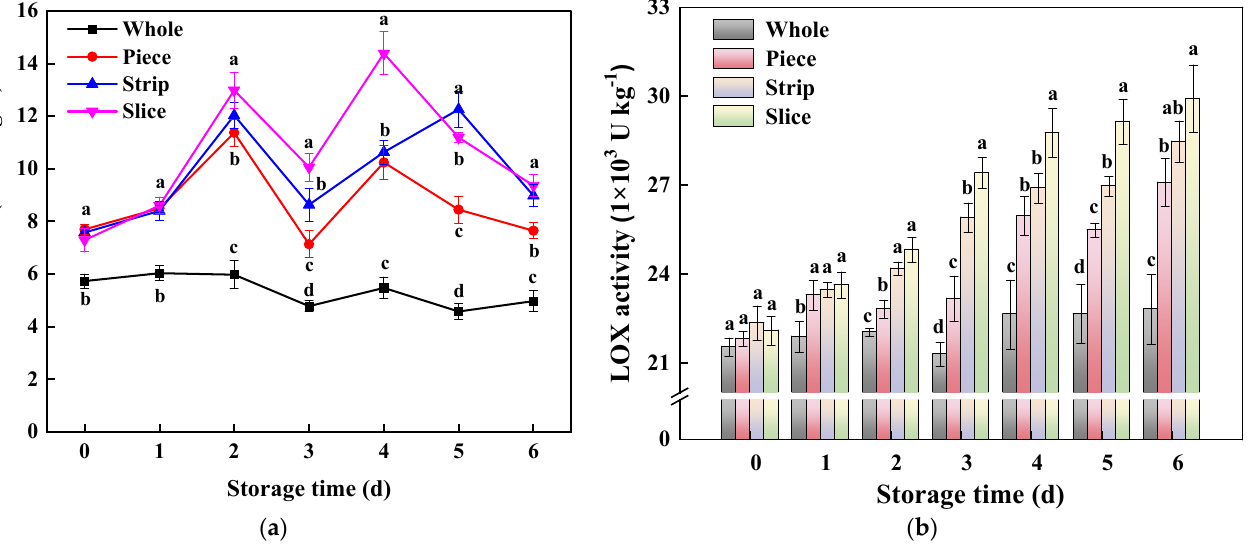
Figure 5. Effect of wounding intensities on MDA content ( a ) and LOX activity ( b ) of fresh-cut pumpkin during storage at 4 °C for 6 days. Vertical bars represent the standard deviation of the mean (n = 3). Different letters indicate significant differences between the groups ( p < 0.05).